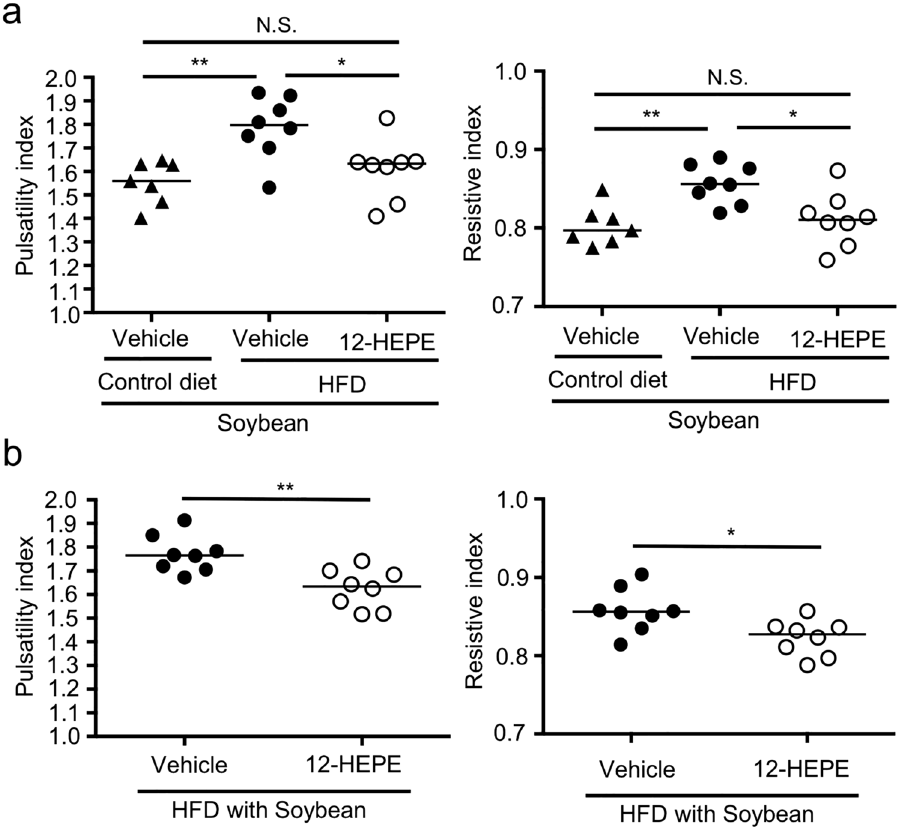
Figure 5. 12-HEPE exerted anti-atherosclerosis activity. ( a ) Mice were fed with either control diet with soybean oil or HFD with soybean oil for 2 months. During that time, mice were intraperitoneally injected with either 12-HEPE (100 ng/mouse) or vehicle 3 times/week, and then pulsatility index and resistive index were examined. Data are combined from 2 independent experiments. Each point represents data from individual mice. Statistical significance of differences was evaluated by means of 1-way ANOVA; * p < 0.05; ** p < 0.01; N.S . not significant. ( b ) Mice were fed with HFD with soybean oil for 2 months. Mice were intraperitoneally injected with either 12-HEPE (100 ng/mouse) or vehicle at the last 4 consecutive days, and then pulsatility index and resistive index were examined 1 day after the final injection with 12-HEPE. Data are combined from 2 independent experiments. Each point represents data from individual mice; n = 7–8/group. Statistical significance of differences was evaluated by means of Mann–Whitney test; ** p <